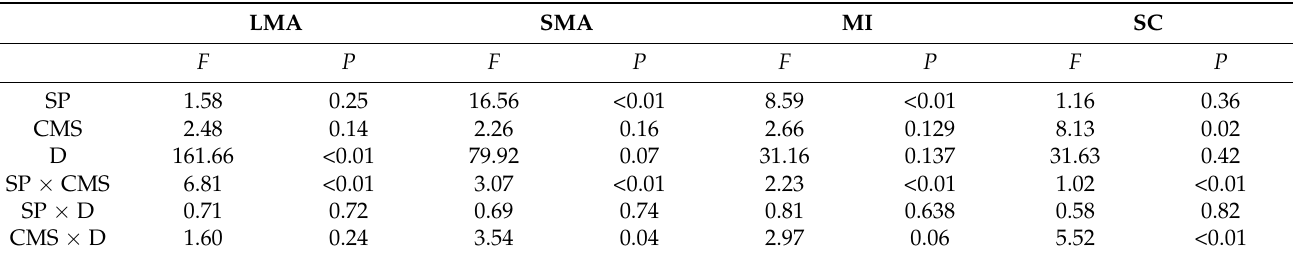
Table 1. Multi-Factor ANOVA for LMA, SMA, MI, and SC as affected by slope position, cropland management system, and depth.